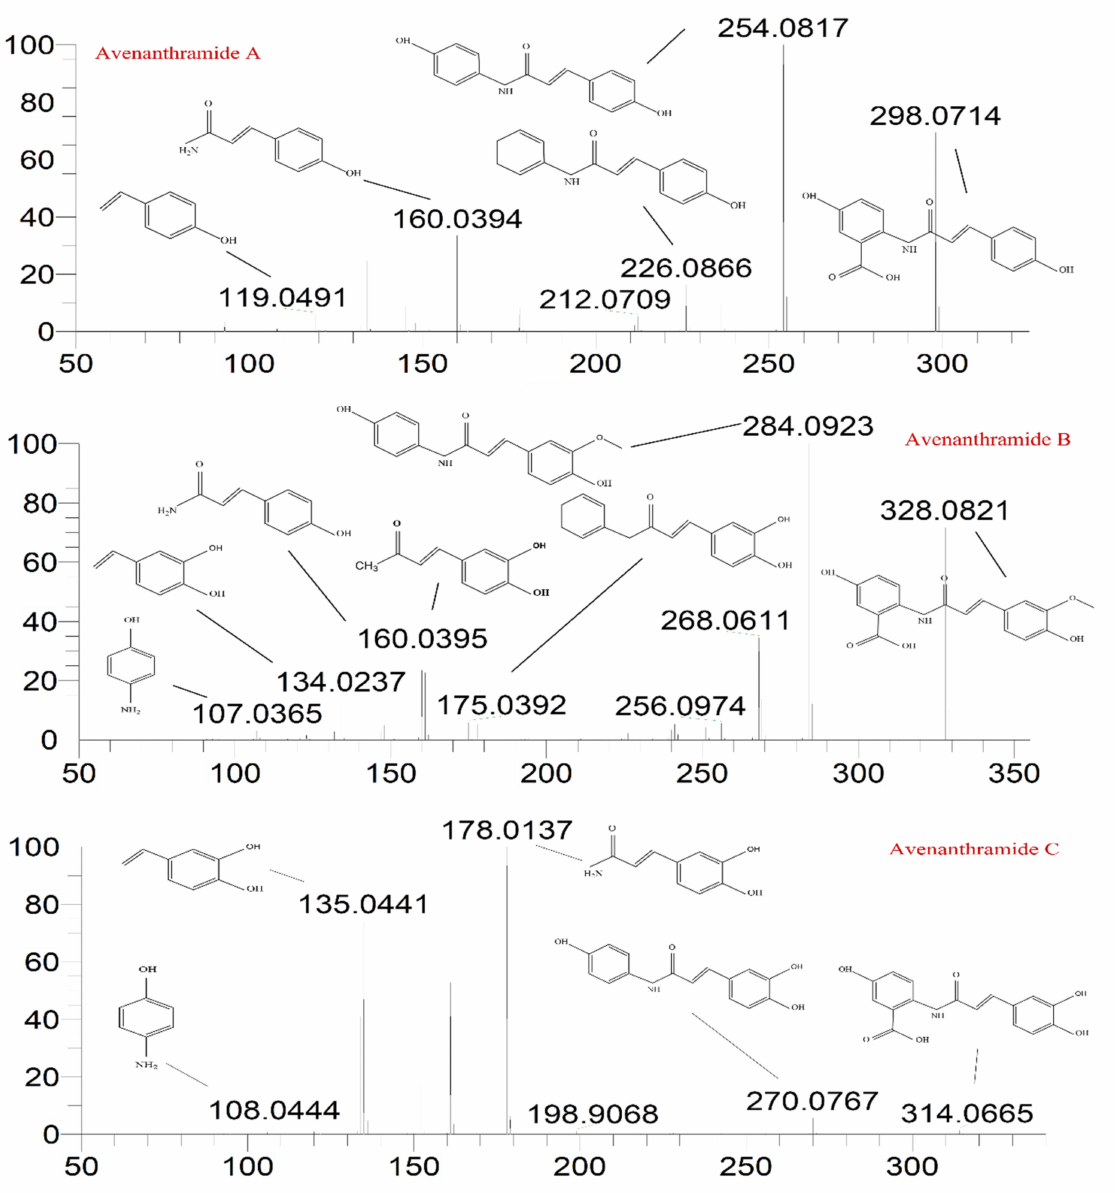
Figure 1. Mass spectra and theoretically possible fragmentation structures of the three